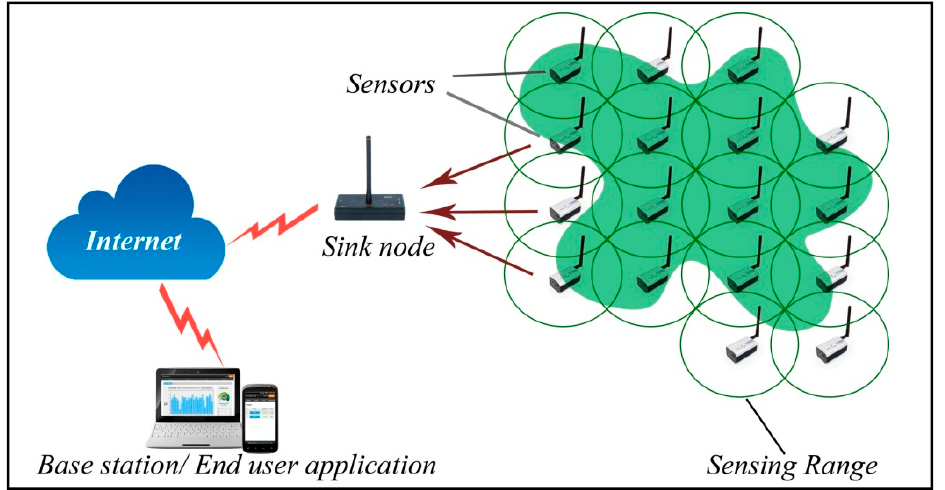
Figure 1. Typical wireless sensor network (WSN) architecture.